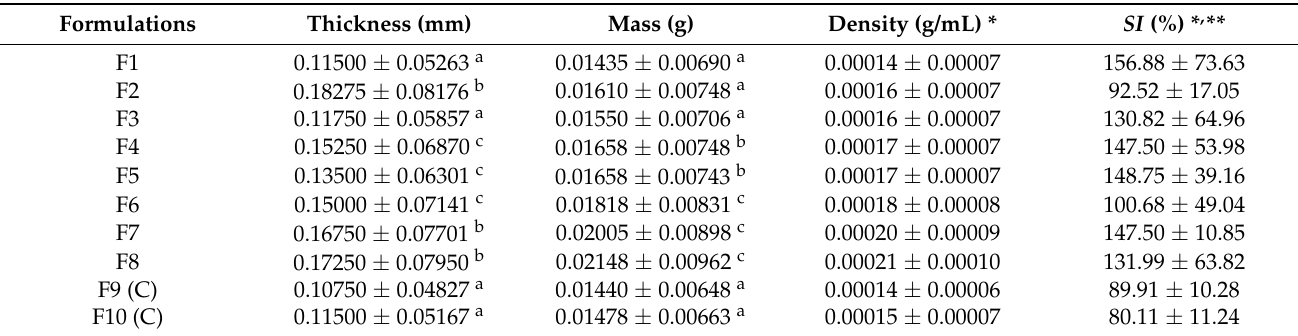
Table 2. Physicochemical characteristics (thickness, mass, density, and swelling index) of film formulations composed of polyvinyl alcohol (PVA), polyvinylpyrrolidone (PVP), ethylcellulose (EC) and tramadol (10%, w / w ). The results represent the mean ( ± standard deviation) of at least three of the replicate samples